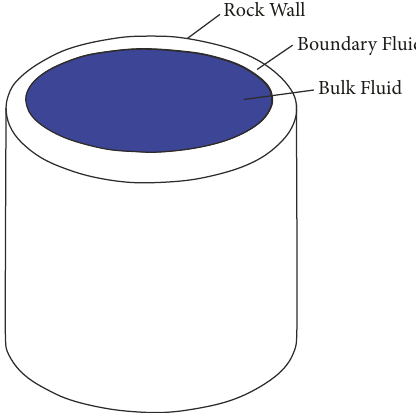
Figure 1: Physical model of percolation fluid in porous